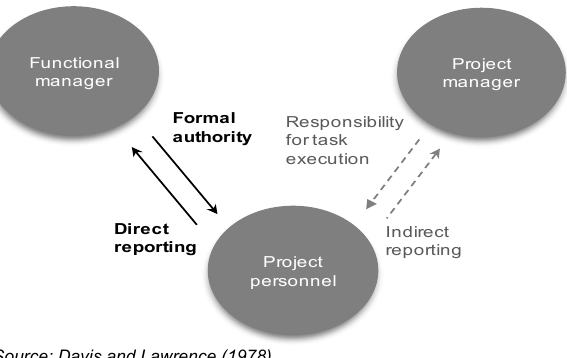
Stakeholder relationships in a matrix organisation